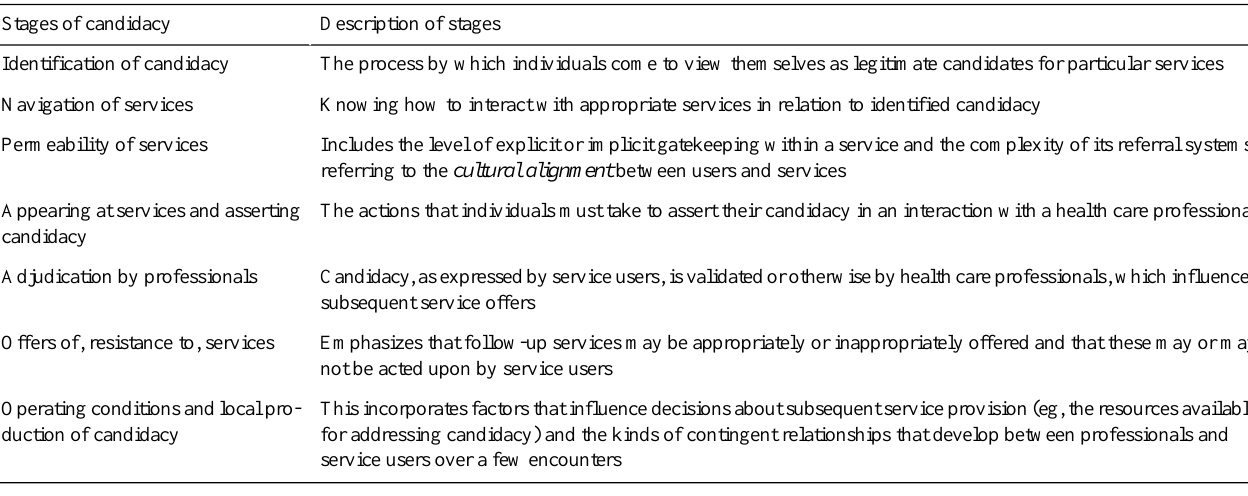
Table 2. Characteristics of the 7 stages of the candidacy framework by Mackenzie et al.